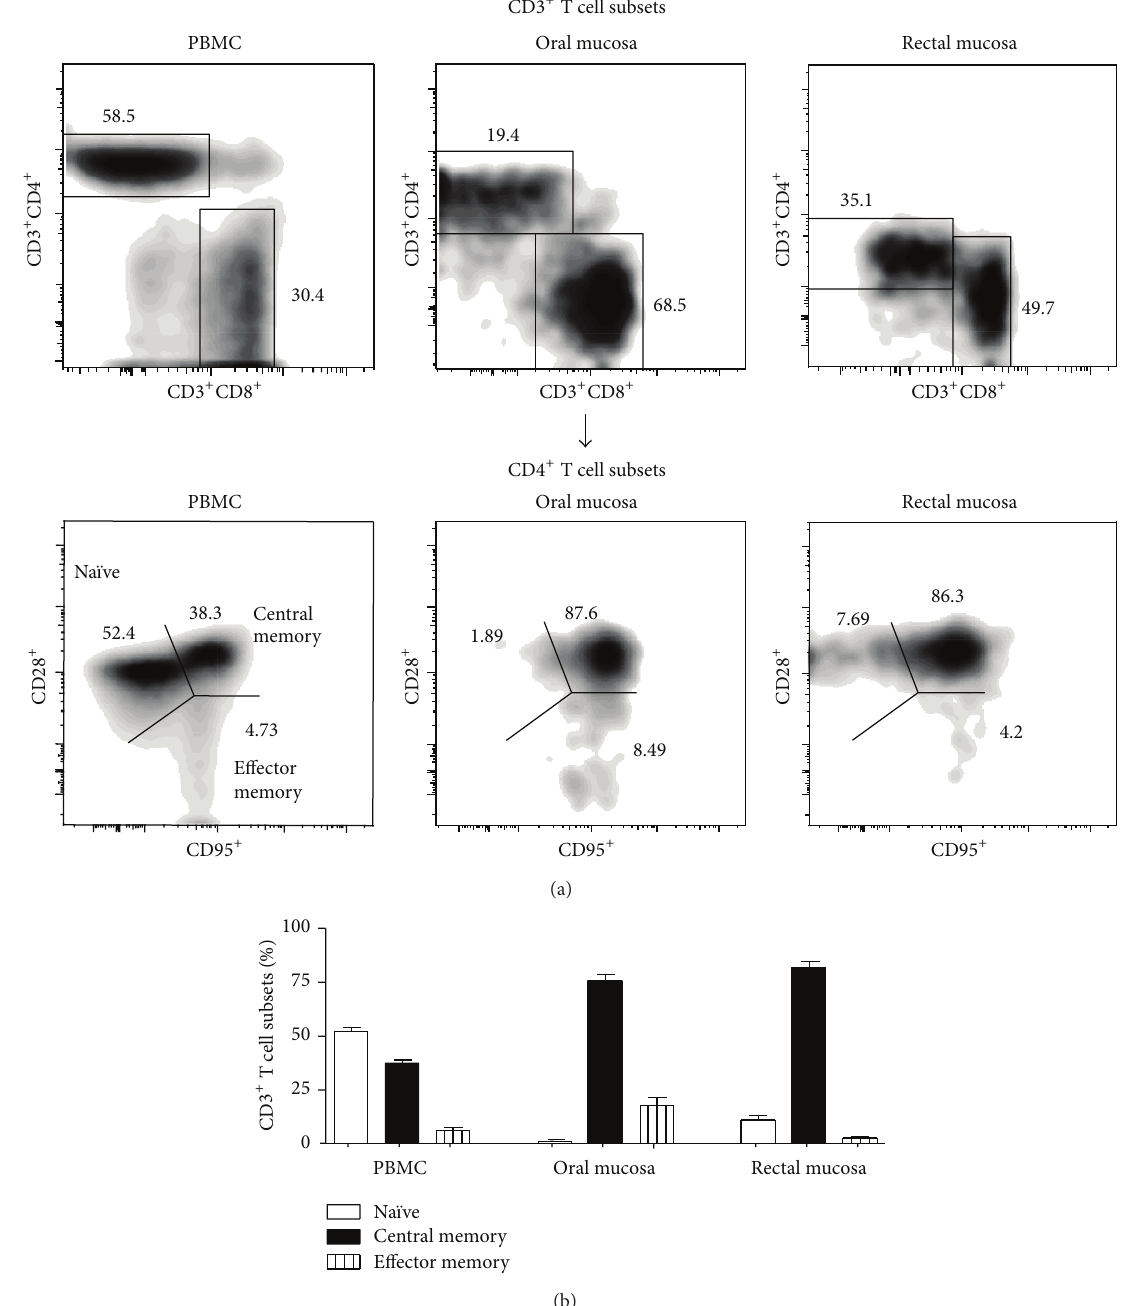
Figure 2: CD4 + T cells in the oral mucosa of healthy animals display a predominantly central memory phenotype. (a) Representative density plots showing the expression of CD28 and CD95 on CD3 + CD4 + T cells from peripheral blood and oral and rectal mucosa. (b) Proportions of na¨ıve, central memory, and effector memory CD4 + T cell subsets in peripheral blood and oral and rectal mucosa.